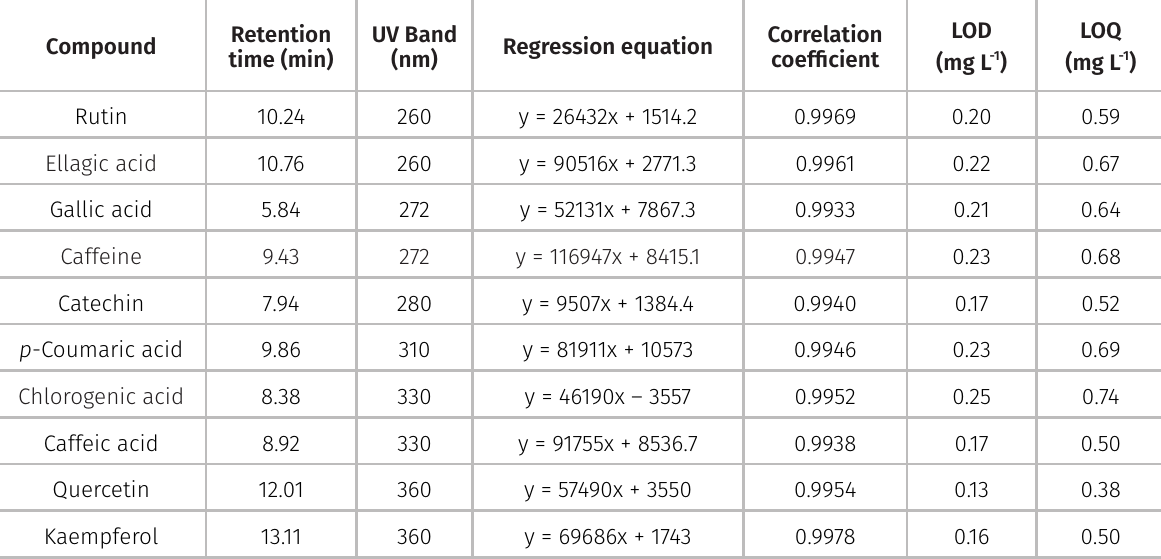
Table III. Chromatographic parameters for the analysis of phenolic acids, flavonoids and caffeine by HPLC-DAD.